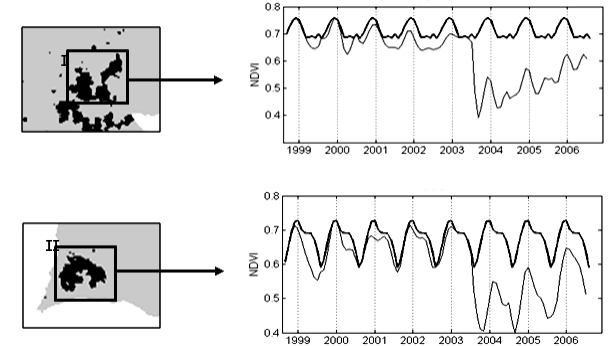
Fig. 3. Spatial distributions of the median of NDVI in May 1999– 2003 over Region I (left panel) and Region II (right panel).